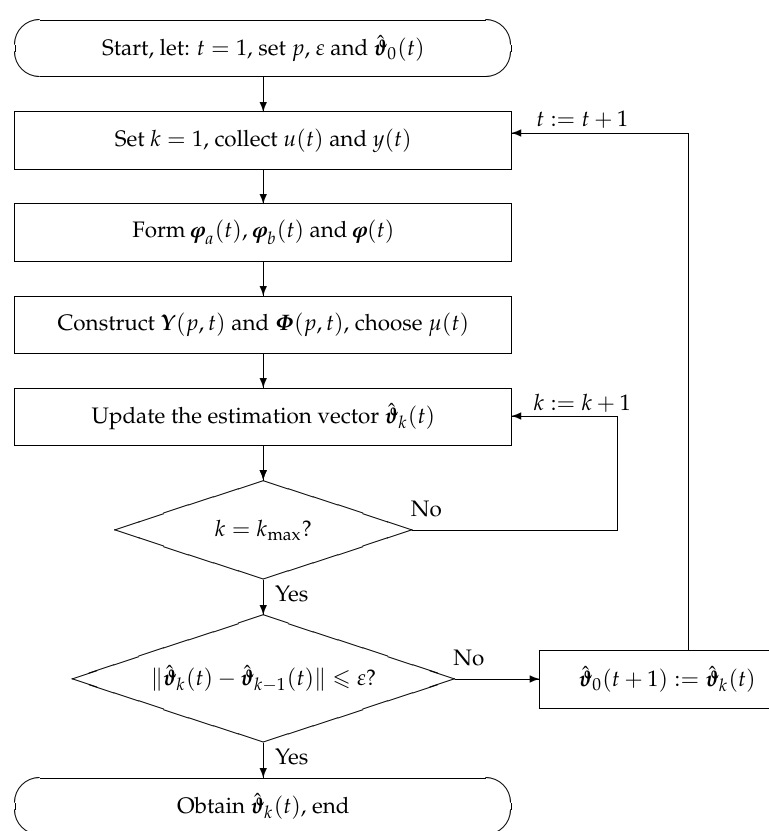
Figure 2. The flowchart of the multi-innovation gradient-based iterative (MIGI)